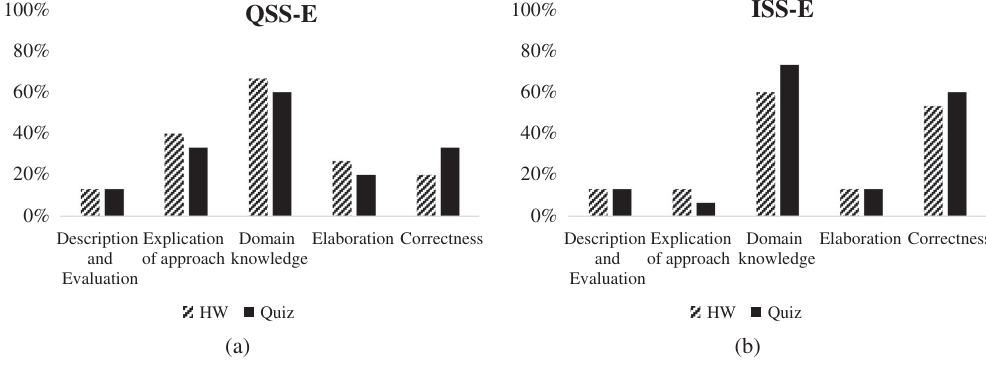
FIG. 8. (a) Percentage of TAs who graded on solution features in the five clusters on the elaborated QM solution QSS-E in the homework and quiz context. (b) Percentage of TAs who graded on solution features in the five clusters on the elaborated introductory physics solution ISS-E in the homework context ( N ¼ 15 TAs).